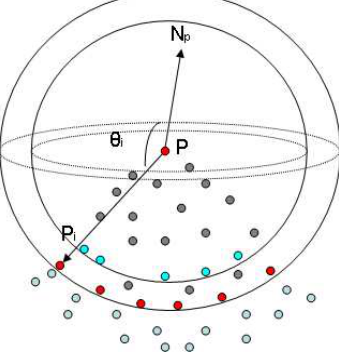
Fig. 1. P and its neighbouring point within two spheres.